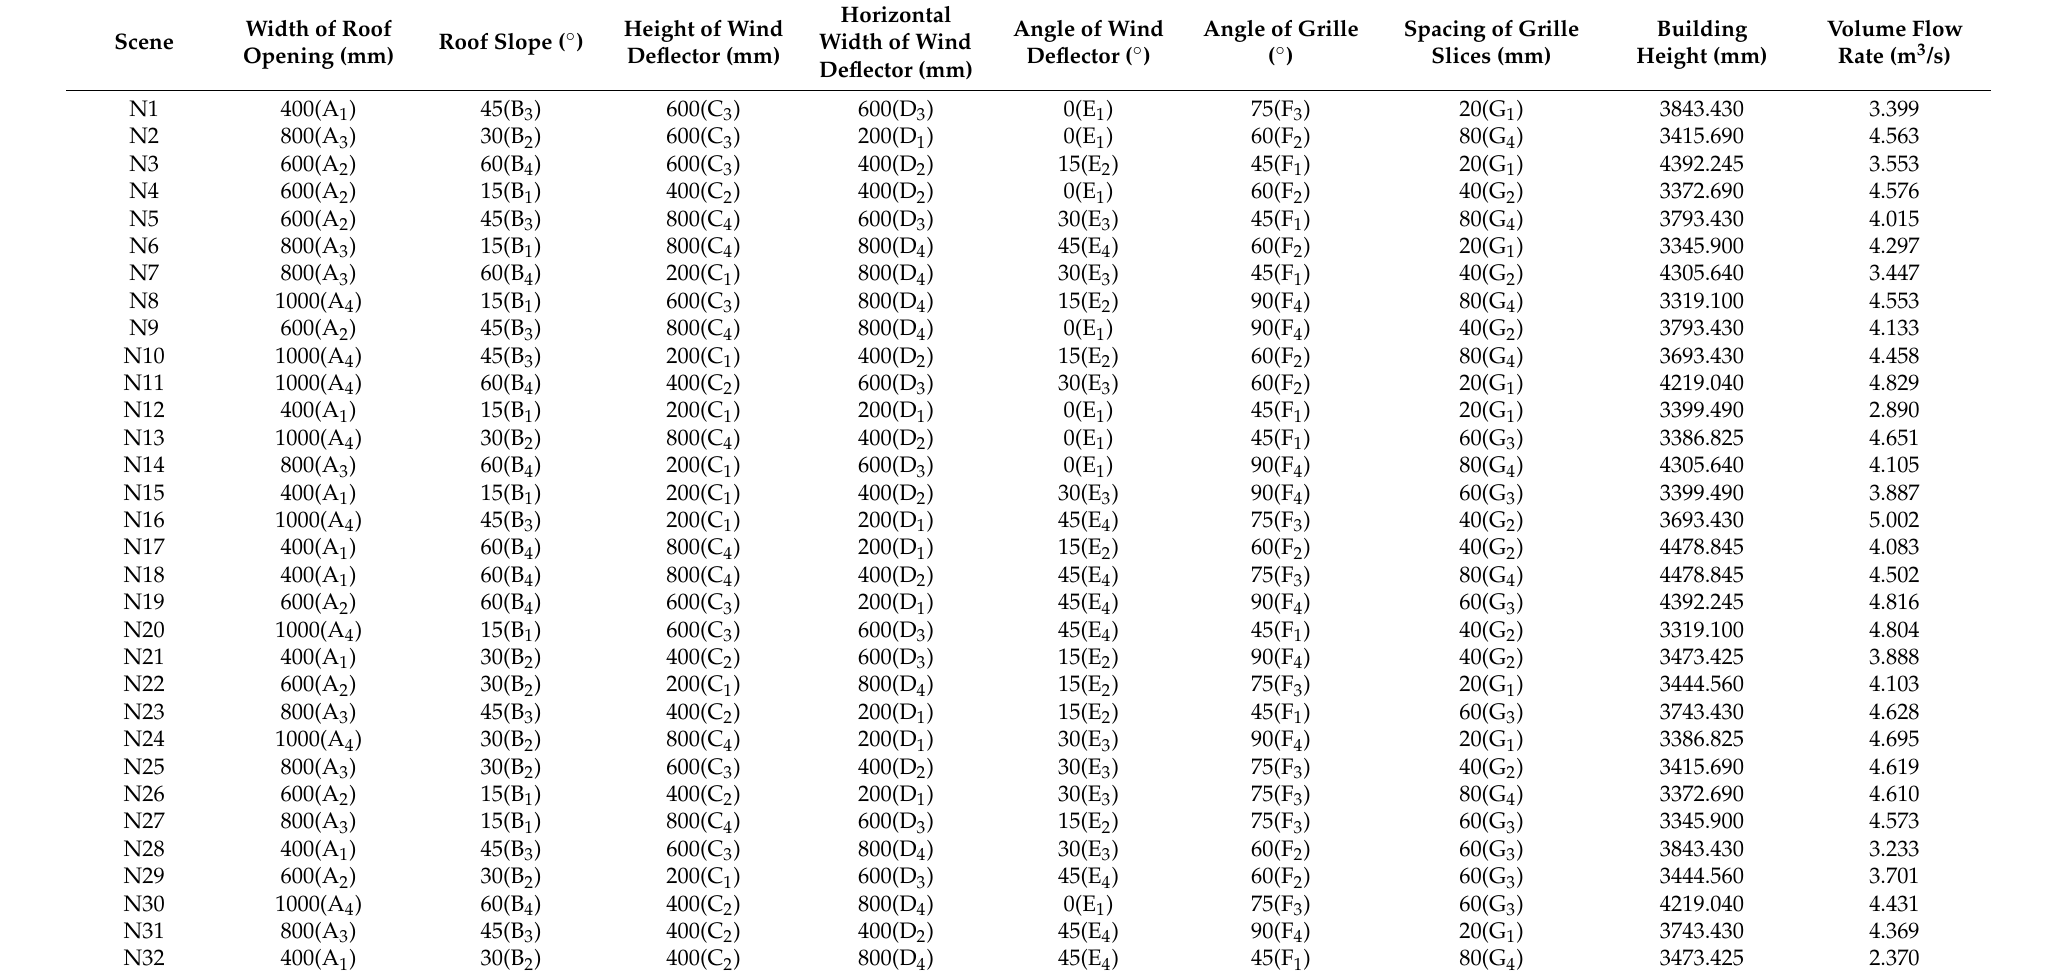
Table 1. Orthogonal design arrangements and